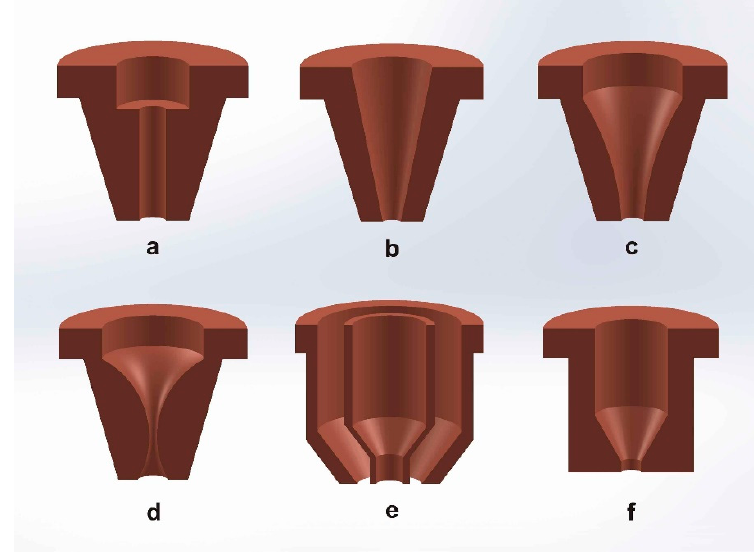
Figure 3. Nozzle geometries commonly used for laser fusion cutting: ( a ) parallel, ( b ) conical, ( c ) converging, ( d ) converging-diverging, ( e ) annular, and ( f ) flat tipped. Reprinted with permission from [22]; Copyright 1986 SPIE.